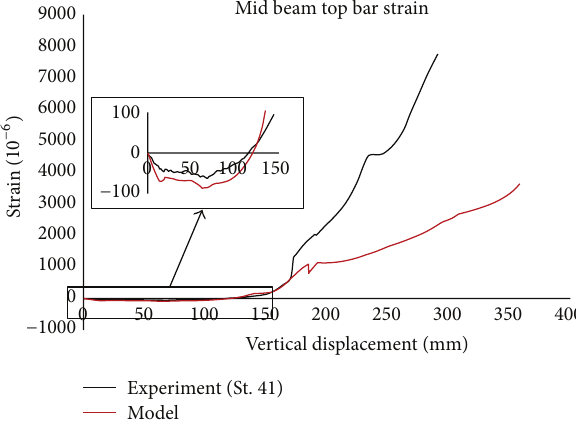
Figure 21: Strain in top reinforcing bar at mid span of beams.